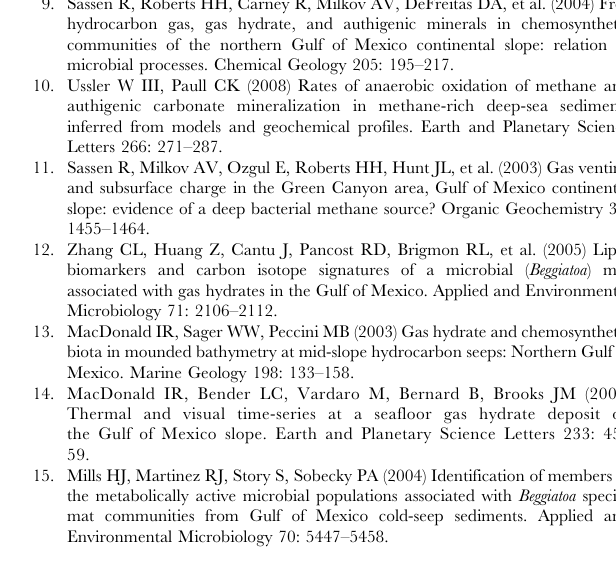
Figure S3 Neighbor-joining tree of cDNA of full-length non- Deltaproteobacterial 16S rRNA sequences for all samples. The nodes are labeled with parsimony-based boostrap values (1000 repetitions) that were over 60%. OTUs are based on 98% similarity. Sequences from dive 3570 are in colors corresponding to those of Fig. 3a groupings.